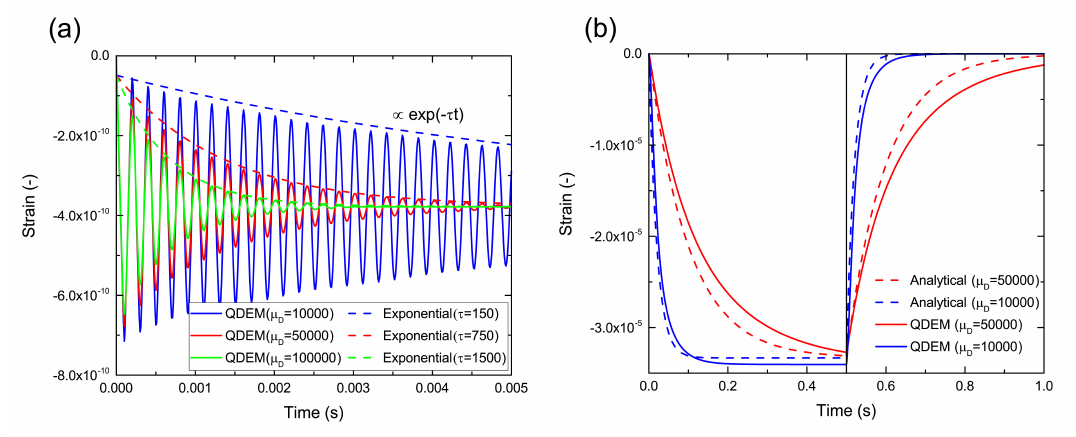
Figure 4. Time variations of strain at the center of the top side of the bar for the ( a ) dynamic regime and ( b ) quasi-static